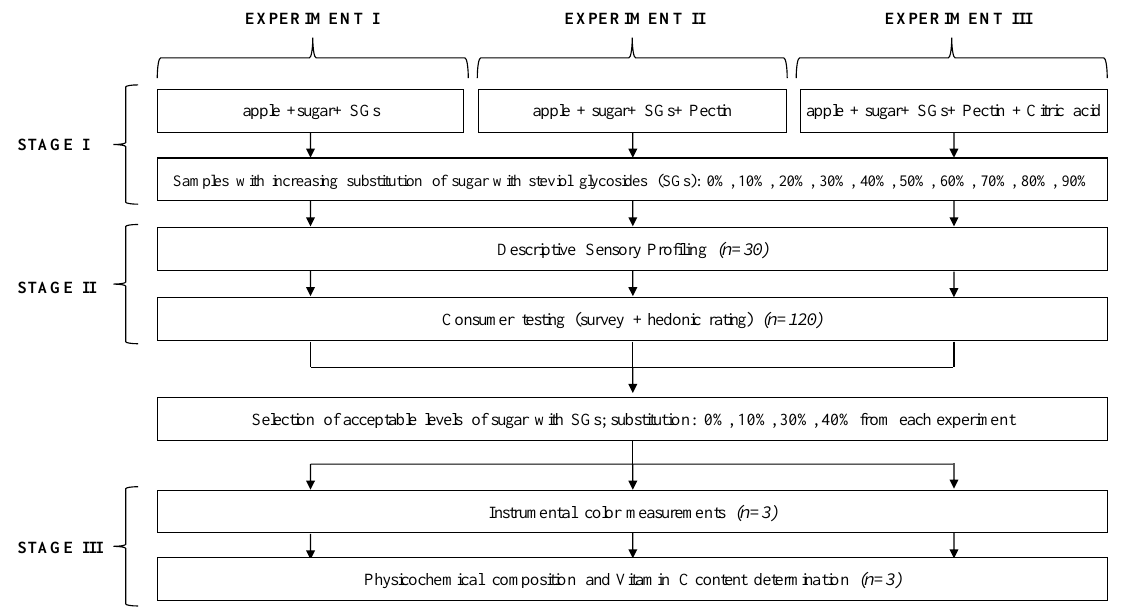
Figure 1. Study design.